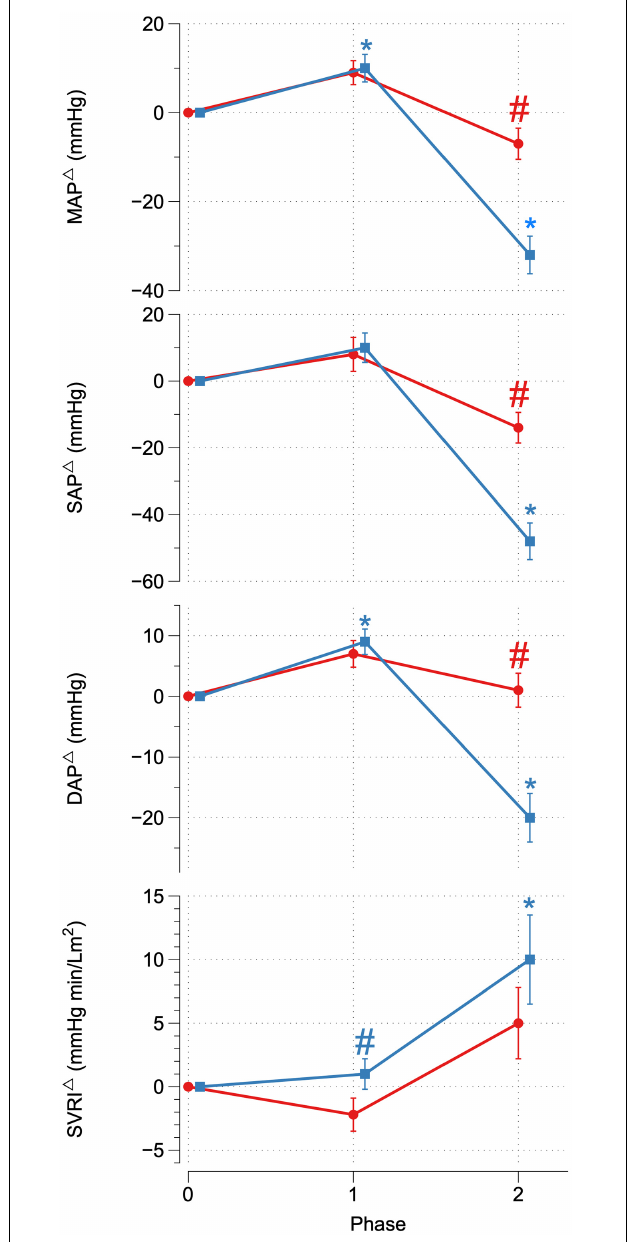
FIGURE 1 | Delta MAP, SAP, DAP, and SVRI for OR (red) and OI (blue) during SHHOC. # Significant difference between groups. *Significant change from P0.